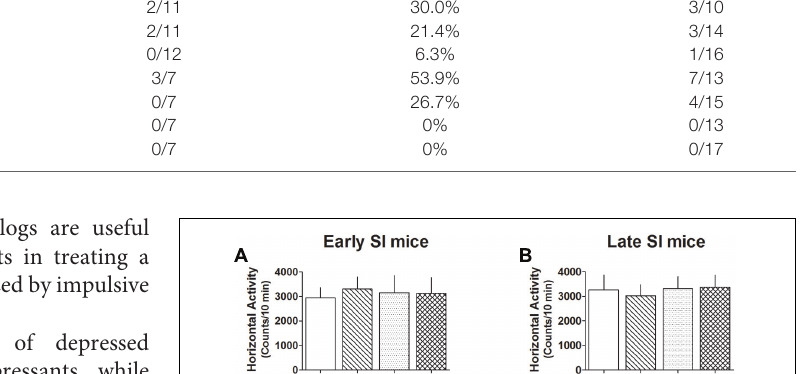
“Non-responders” Late SI mice (%) Late SI mice (n) Early SI mice (%) Early SI mice (n)